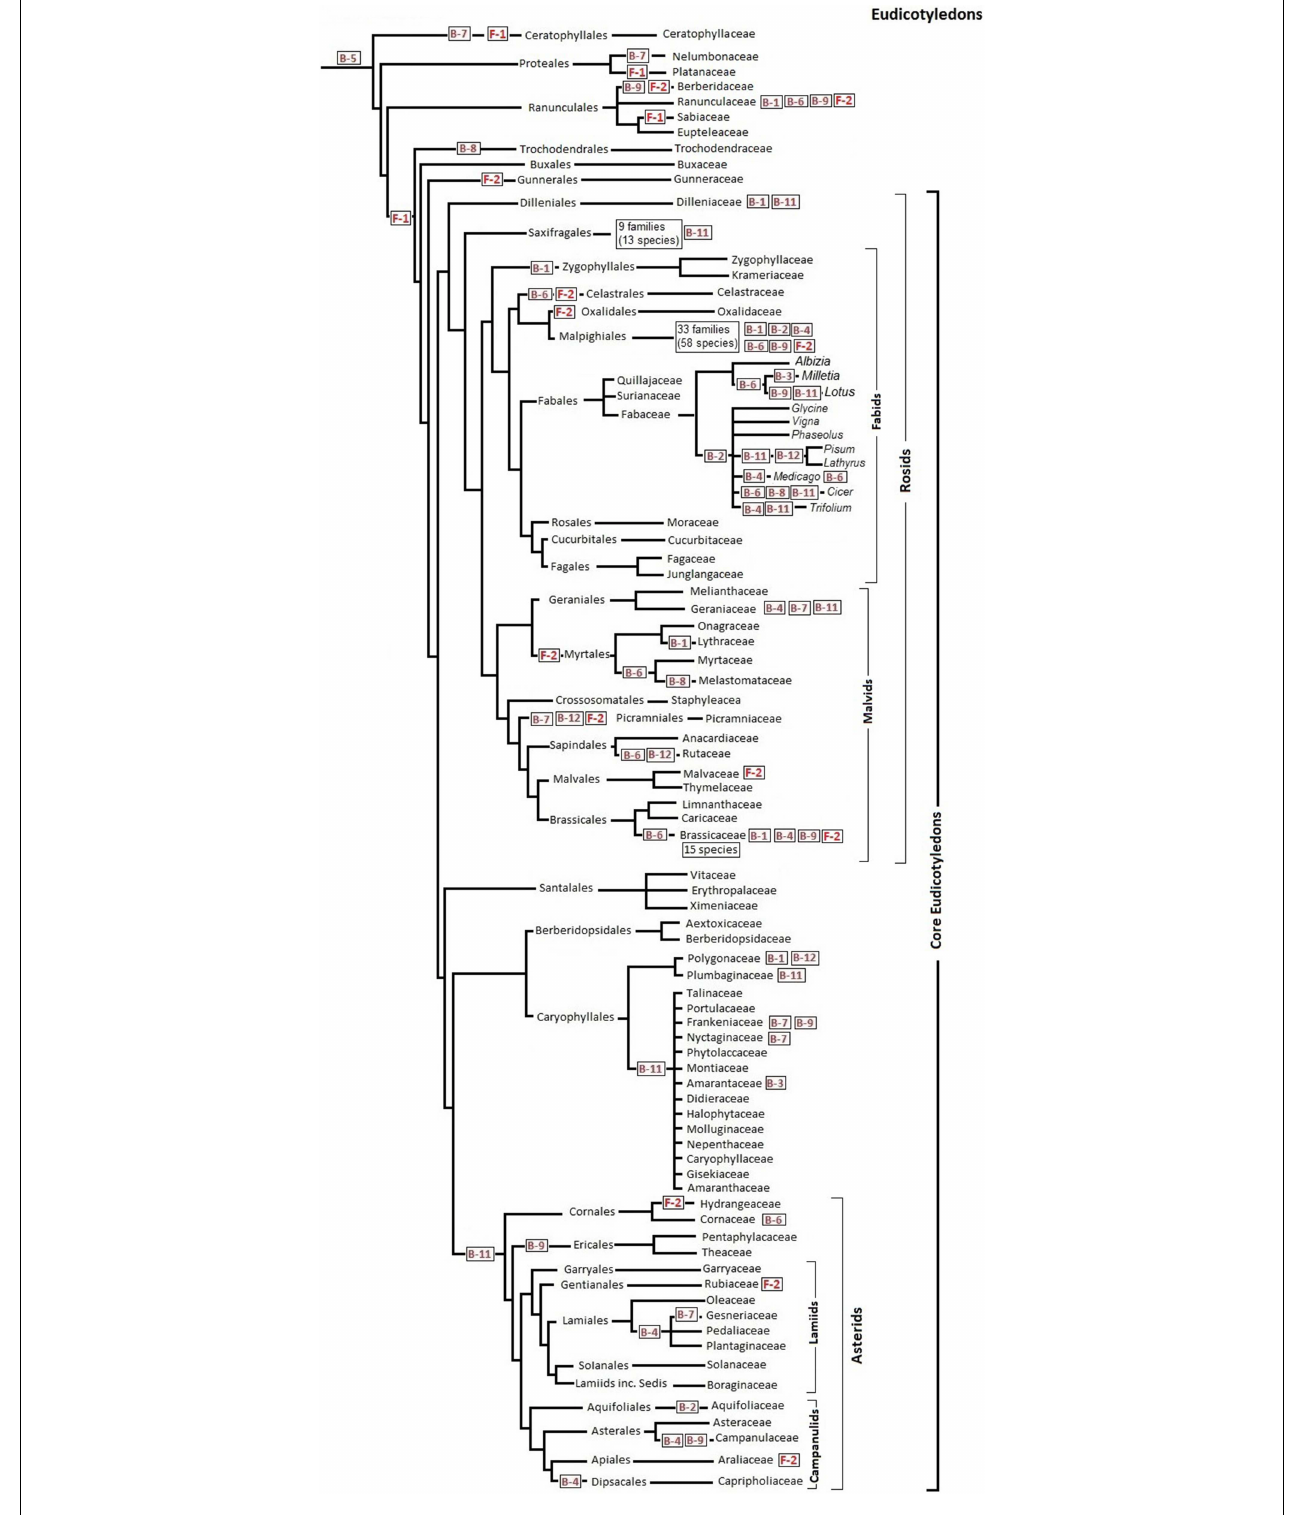
FIGURE 1 | C-to-T reversion of editing sites of ndhB and ndhF genes during eudicotyledon phylogeny. Reference phylogenetic trees are slightly modified for insertion of the main editing site correction stages. Specific editing sites (in red squared) are C-to-T corrected in all